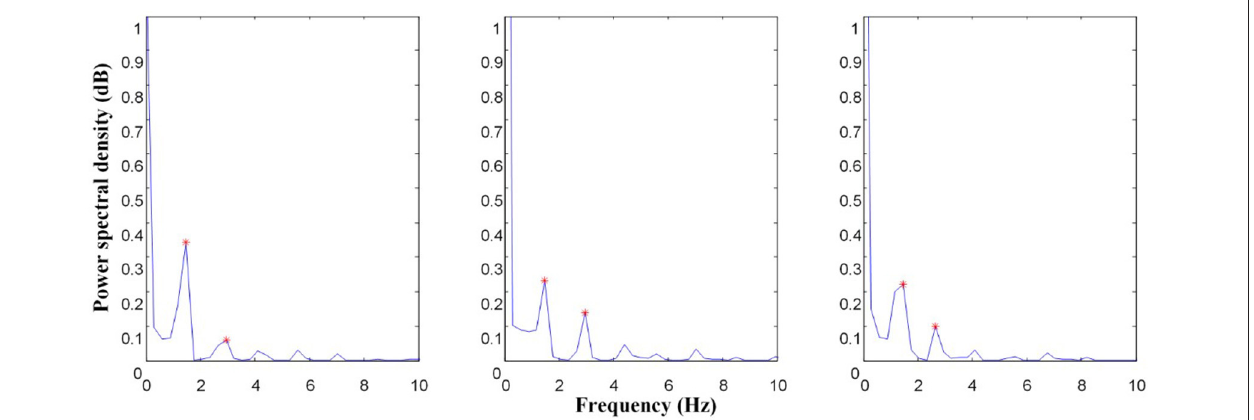
FIGURE 2 | Power spectrum comparison of left carotid (LC) common artery before, during, and after EECP; The asterisk (*) is the primary peak (x1, y1) and secondary peak (x2, y2) of the power spectrum.